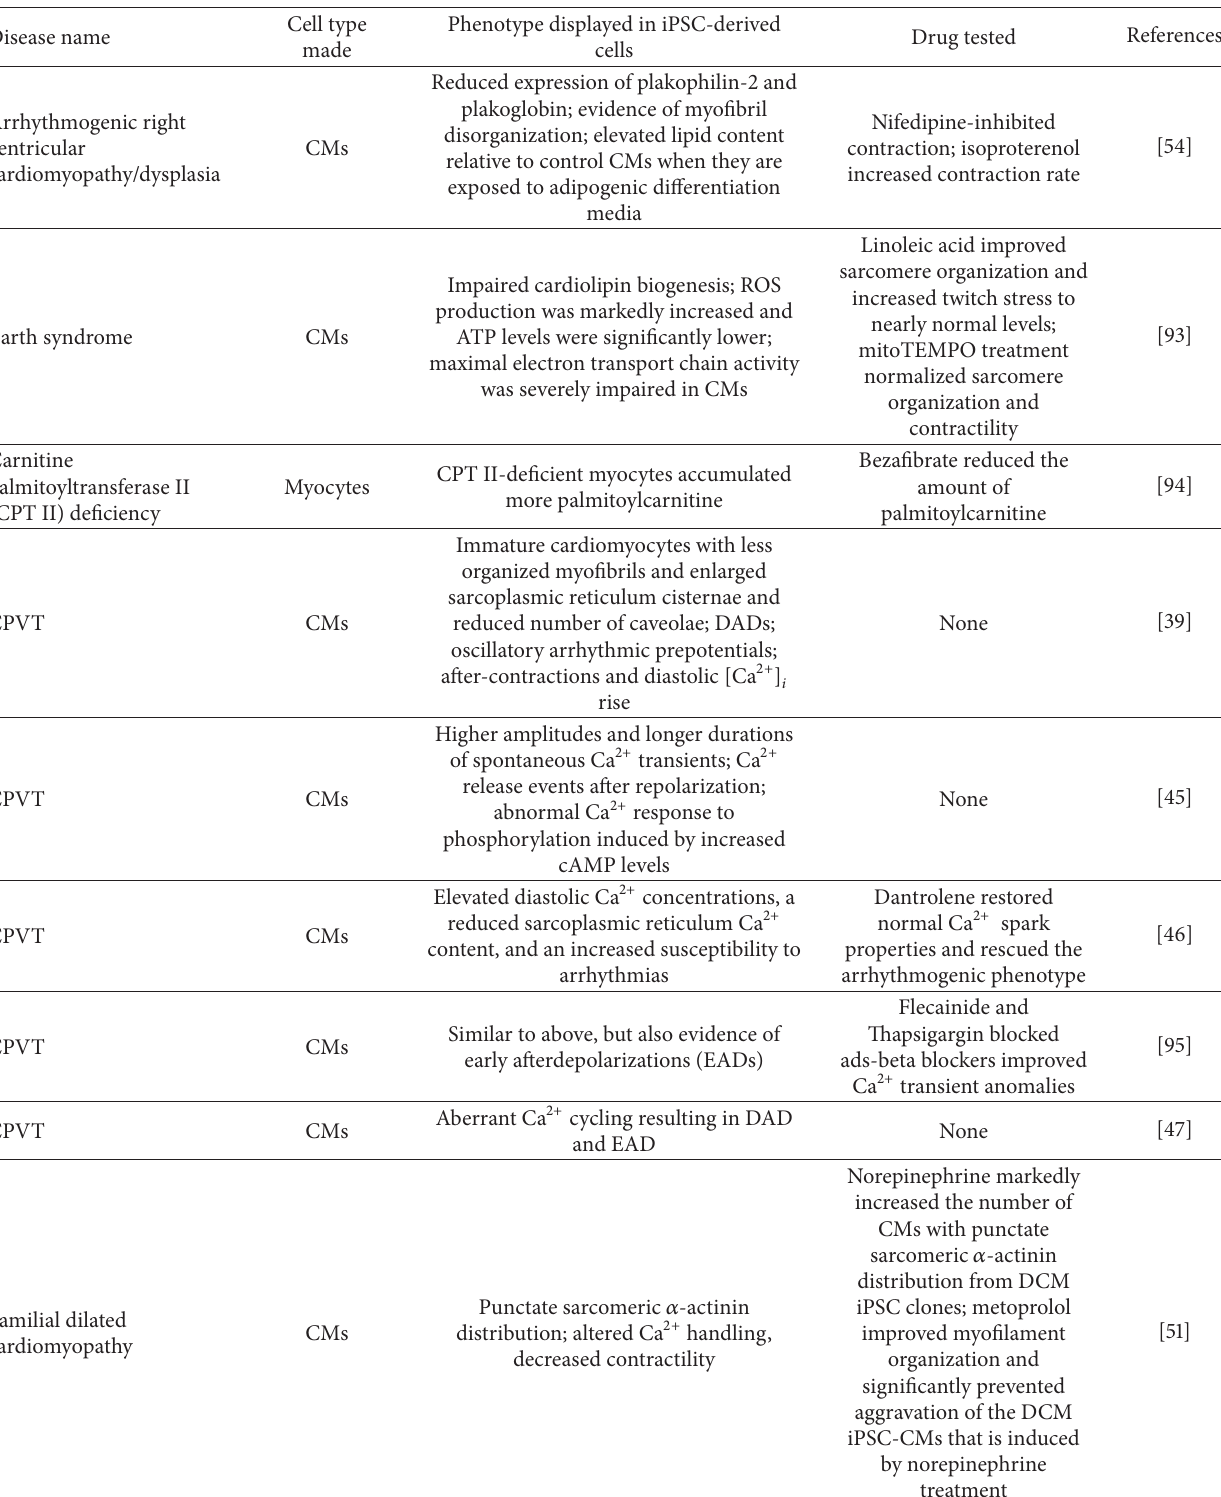
Table 6: Summary of published studies in cardiovascular disease with patient-specific